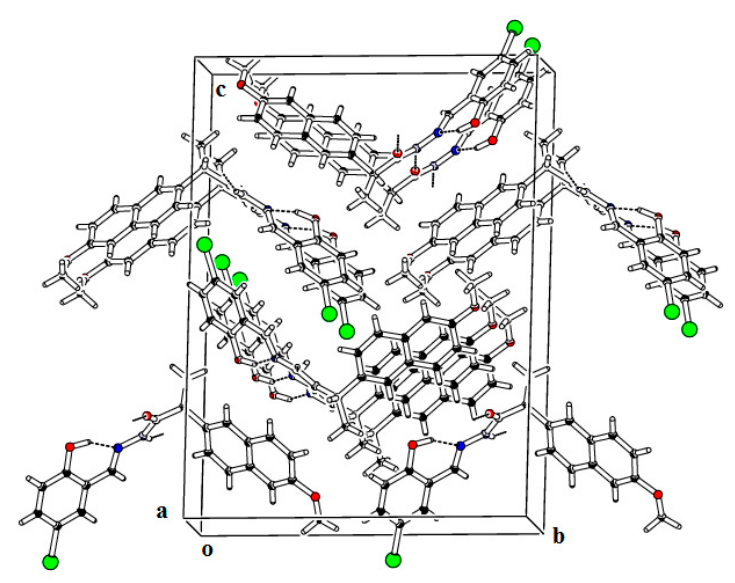
Figure 1. ORTEP diagram of the Schiff base ( 5 ) with thermal ellipsoids drawn at the 50% probability level. The H-atoms are shown as small circles of arbitrary radii.